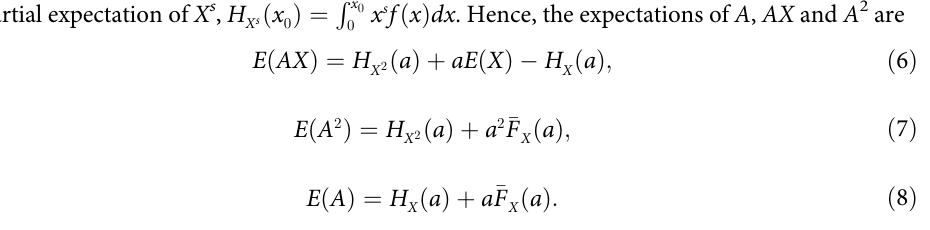
Table 1. Definition of A and C if an absolute deductible with parameter a � 0 is applied. X A C X < a X 0 X > a a X −